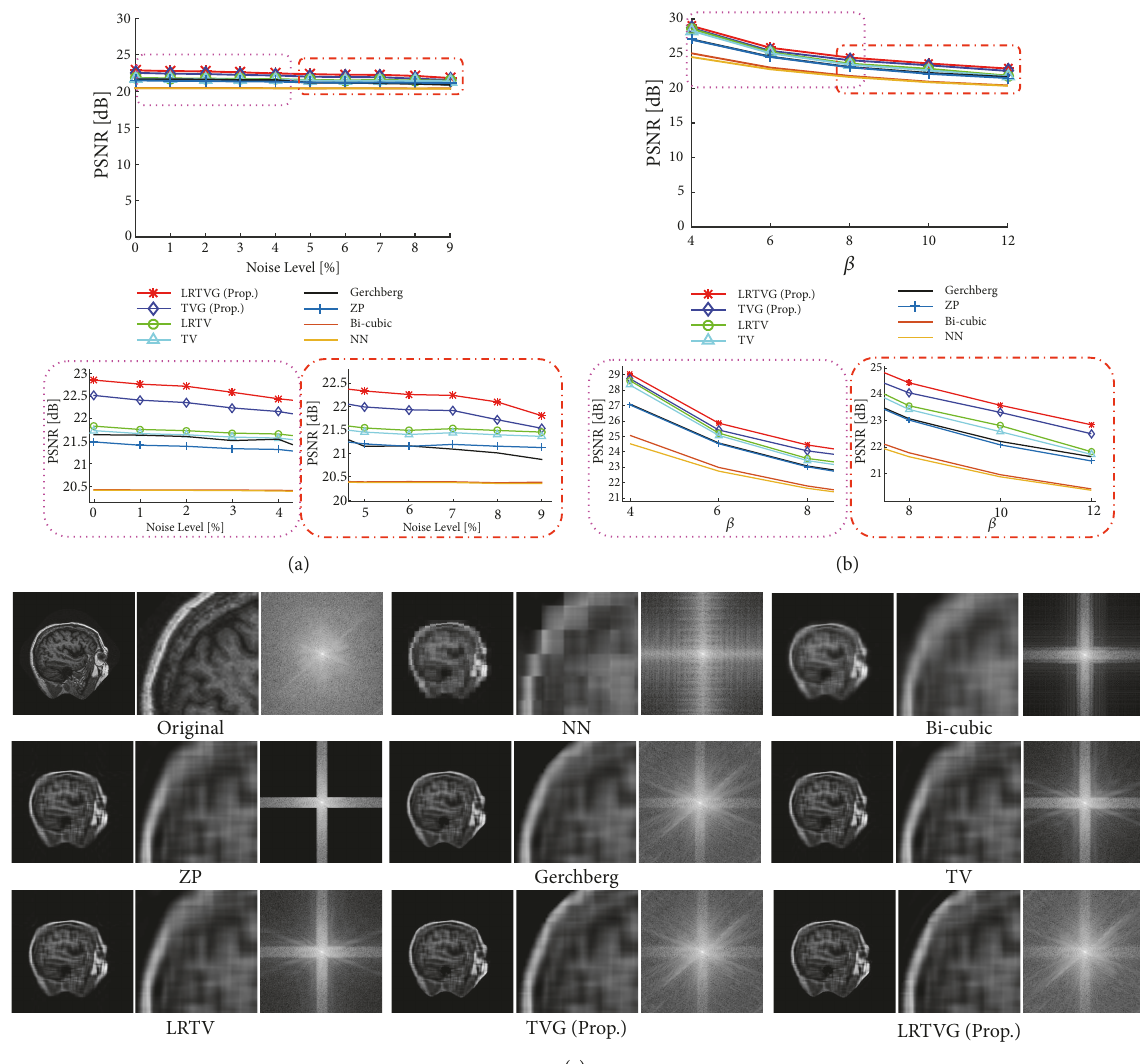
Figure 9: Experimental results obtained for an image from OASIS. (a) PSNR in terms of the Gaussian noise level (upper) and enlarged views (lower). (b) PSNR in terms of the scaling factor 𝛽 (upper) and enlarged views (lower). (c) Reconstructed images and spectra obtained with 𝛽 = 12